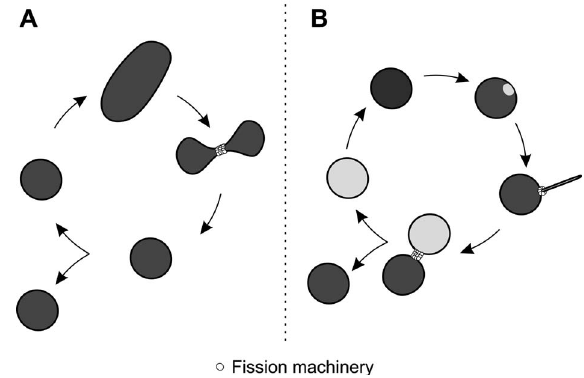
Figure 1 Stochastic versus asymmetric peroxisome proliferation. (A) In a simplified model for peroxisome proliferation, a peroxi- some grows and elongates and, upon a critical size, the membrane is constricted and divides through fission. Herein, the inheritance of membranes and proteins is stochastic. (B) In asymmetric prolifera- tion, the peroxisome becomes polarized and its membrane elongates at a specific site reorganizing membrane proteins. The fission machinery assembles at the site of membrane protrusion and import of new matrix proteins assembles a daughter peroxisome which sep- arates from the mother organelle through membrane scission. S. pombe (88). In human cells, functional microtubules